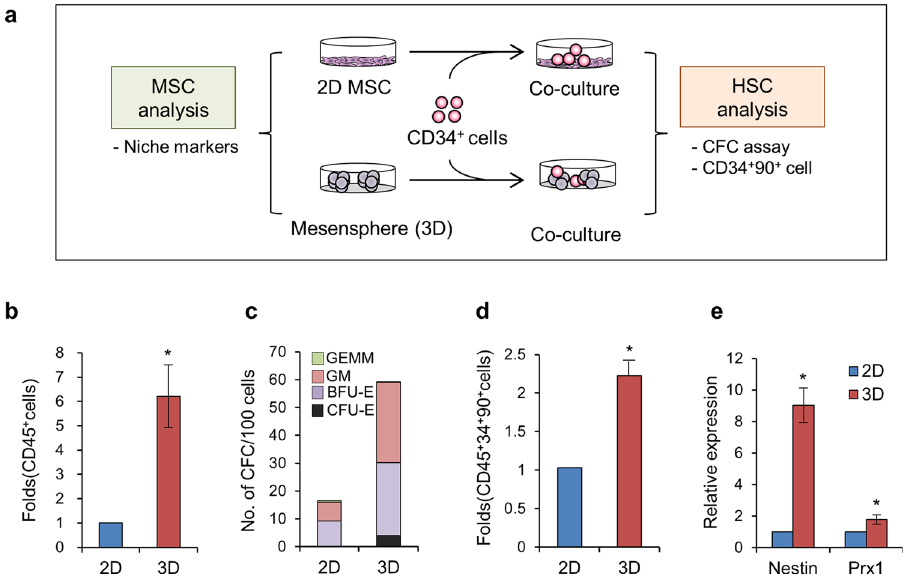
Figure 4. 3D spheroid MSCs represented the activated niche for HSCs. ( a ) Schematic illustration of the experimental scheme. ( b ) Expansion of hematopoietic cells after coculture with 2D or 3D MSCs for 5 days. Shown are the mean ± SEM of total CD45 + cells (three experiments, n = 3; * p < 0.05). ( c ) Expansion of colony- forming hematopoietic progenitors (CFCs). Mean numbers of CFCs derived from 100 cultured hematopoietic cells (CD45 + ) after coculture are shown with types of each colony for erythroid (CFU-E, BFU-E), granulocyte- macrophage (CFU-GM) and mixed (CFU-GEMM) (three experiments). ( d ) Expansion of undifferentiated hematopoietic progenitor (CD34 + CD90 + ) cells. Fold changes in coculture with 3D MSCs relative to coculture with 2D MSCs are shown (mean ± SEM, three experiments, n = 3; * p < 0.05). ( e ) Fold changes in expression for niche markers in MSCs determined by RQ-PCR after normalization with GAPDH (mean ± SEM, n = 3; * p <